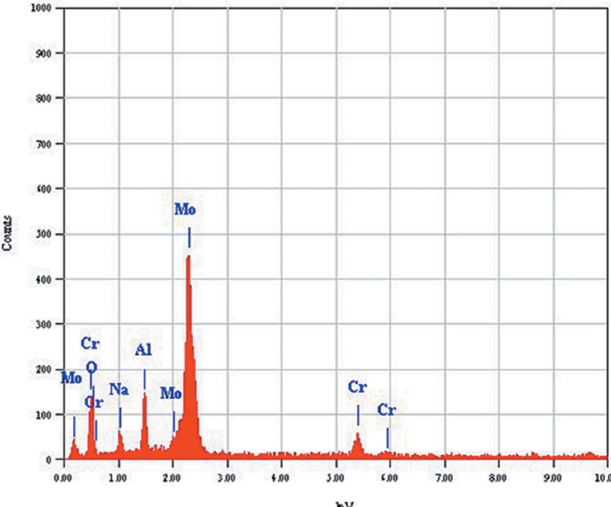
Figure 7 EDX analysis of the sample confirming the presence of aluminium in